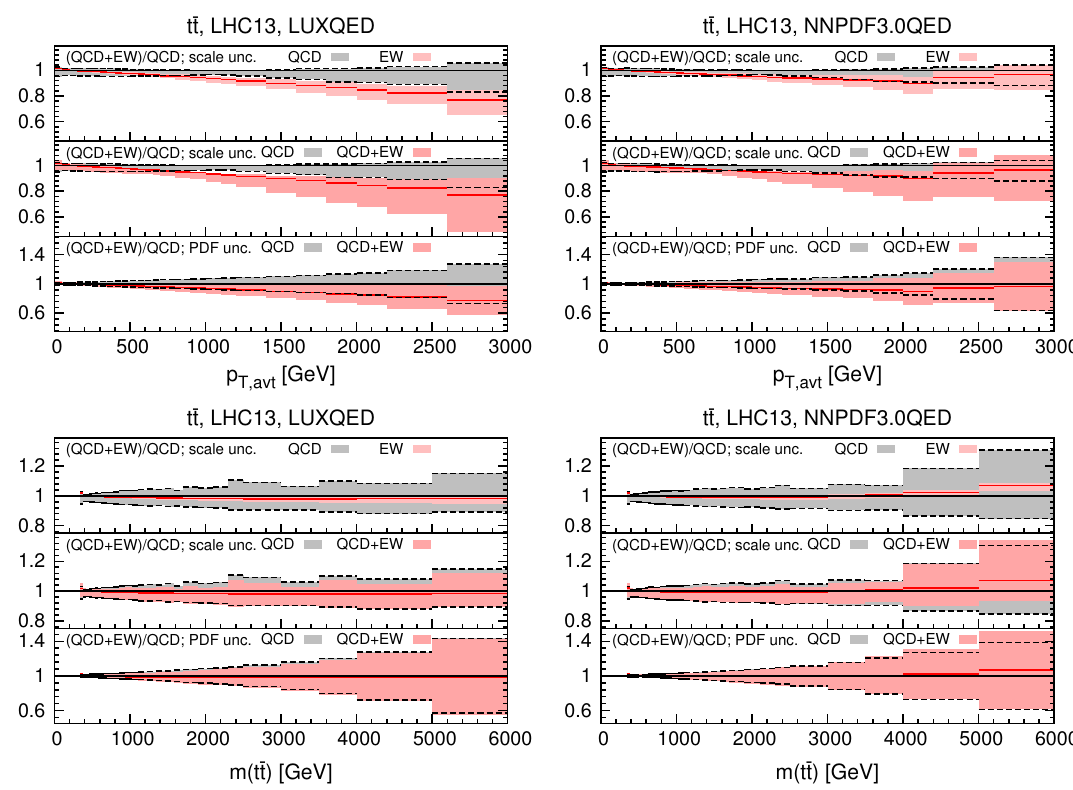
Figure 2 . Di(cid:11)erential distributions for p T; avt and m ( t (cid:22) t ) at 13 TeV. Predictions are based on the additive approach. The format of the plots is described in the